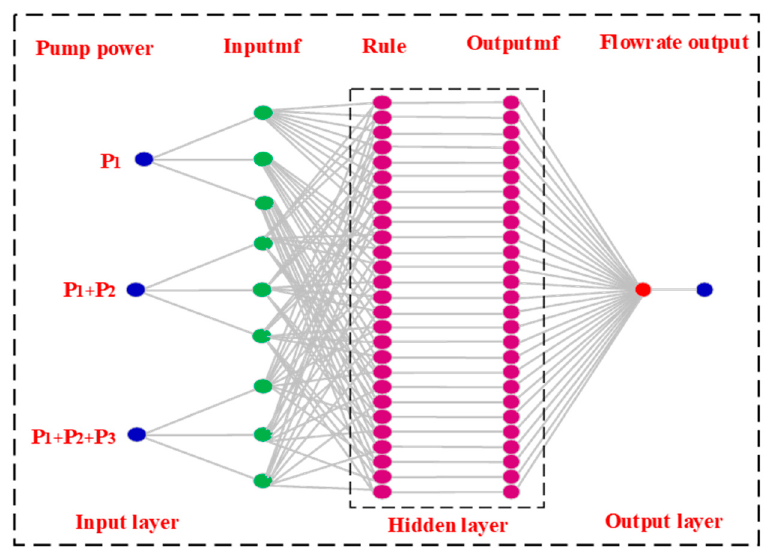
Figure 10. ANFIS model structure.